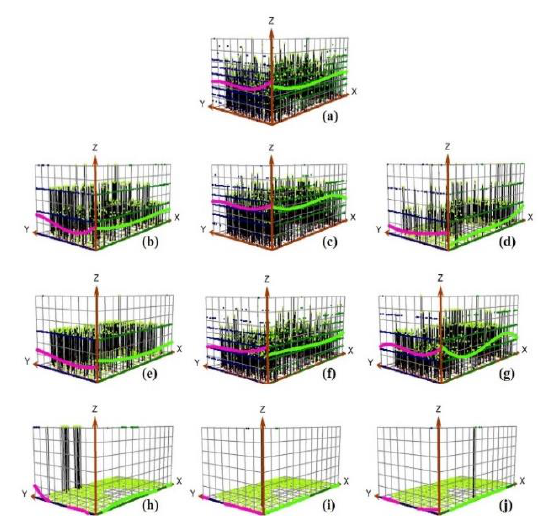
Figure 10 . The outcomes of trend analysis which can reflect trends of various